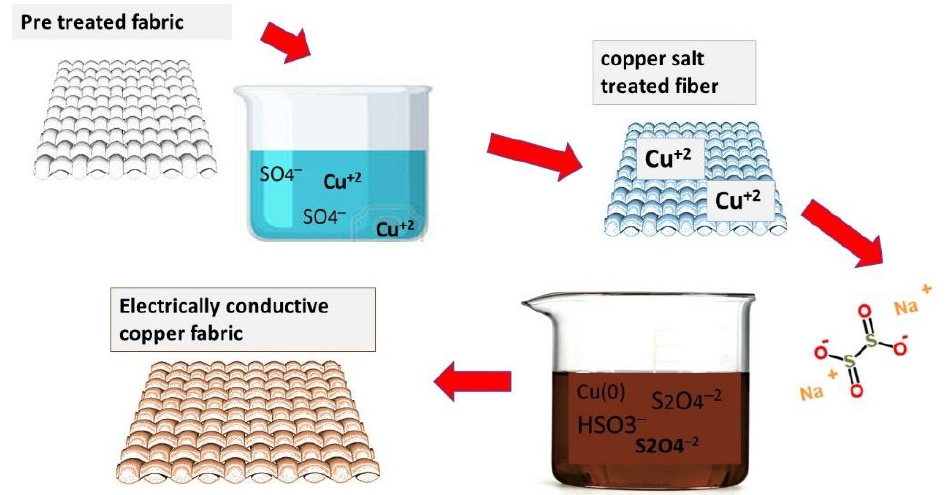
Figure 14. Mechanism for the attachment of copper particles on cotton fabric.